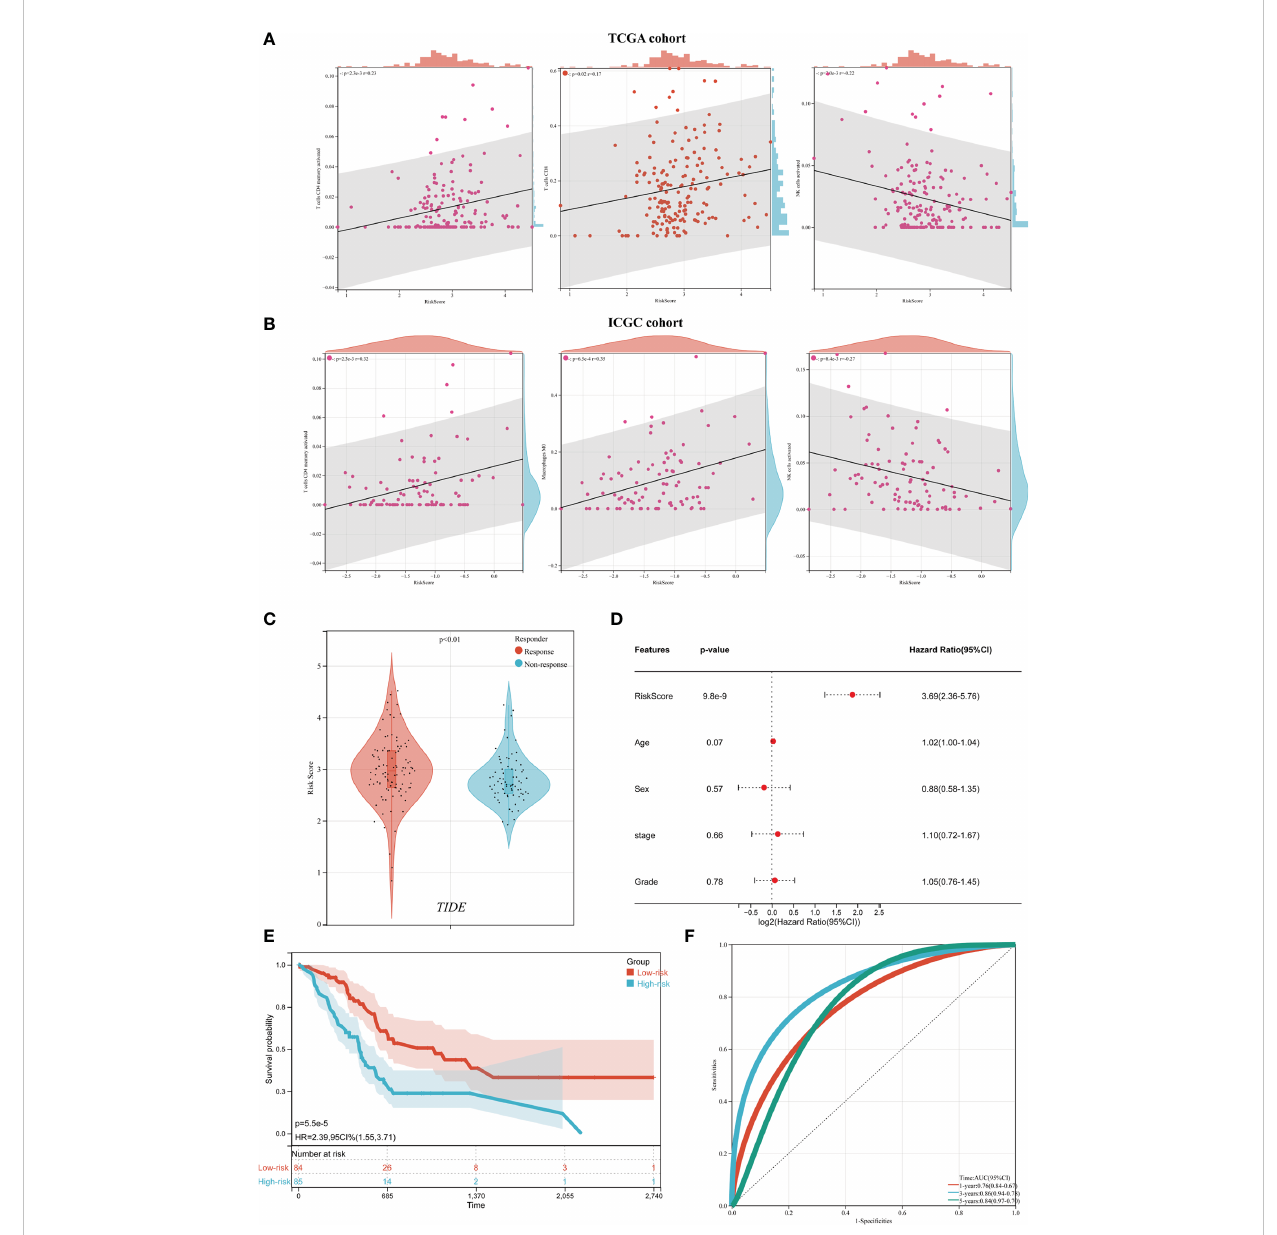
FIGURE 7 The relationship between the tumor microenvironment and the ICD risk pro fi le. (A, B) Scatter plots demonstrate the relationship between risk score and activated CD4 memory cells, T cells CD8 and activated NK cells in fi ltration (A) , which was further supported by the ICGC cohort (B) ; (C) The violin plot depicted the relationship between ICD risk score and immunotherapy response. (D) multivariate Cox analyses assessed the independent prognostic value of the ICD risk signature in PDAC patients. (E, F) Survival analysis was used to construct a risk model in the TCGA dataset (E) and ROC curve (F)